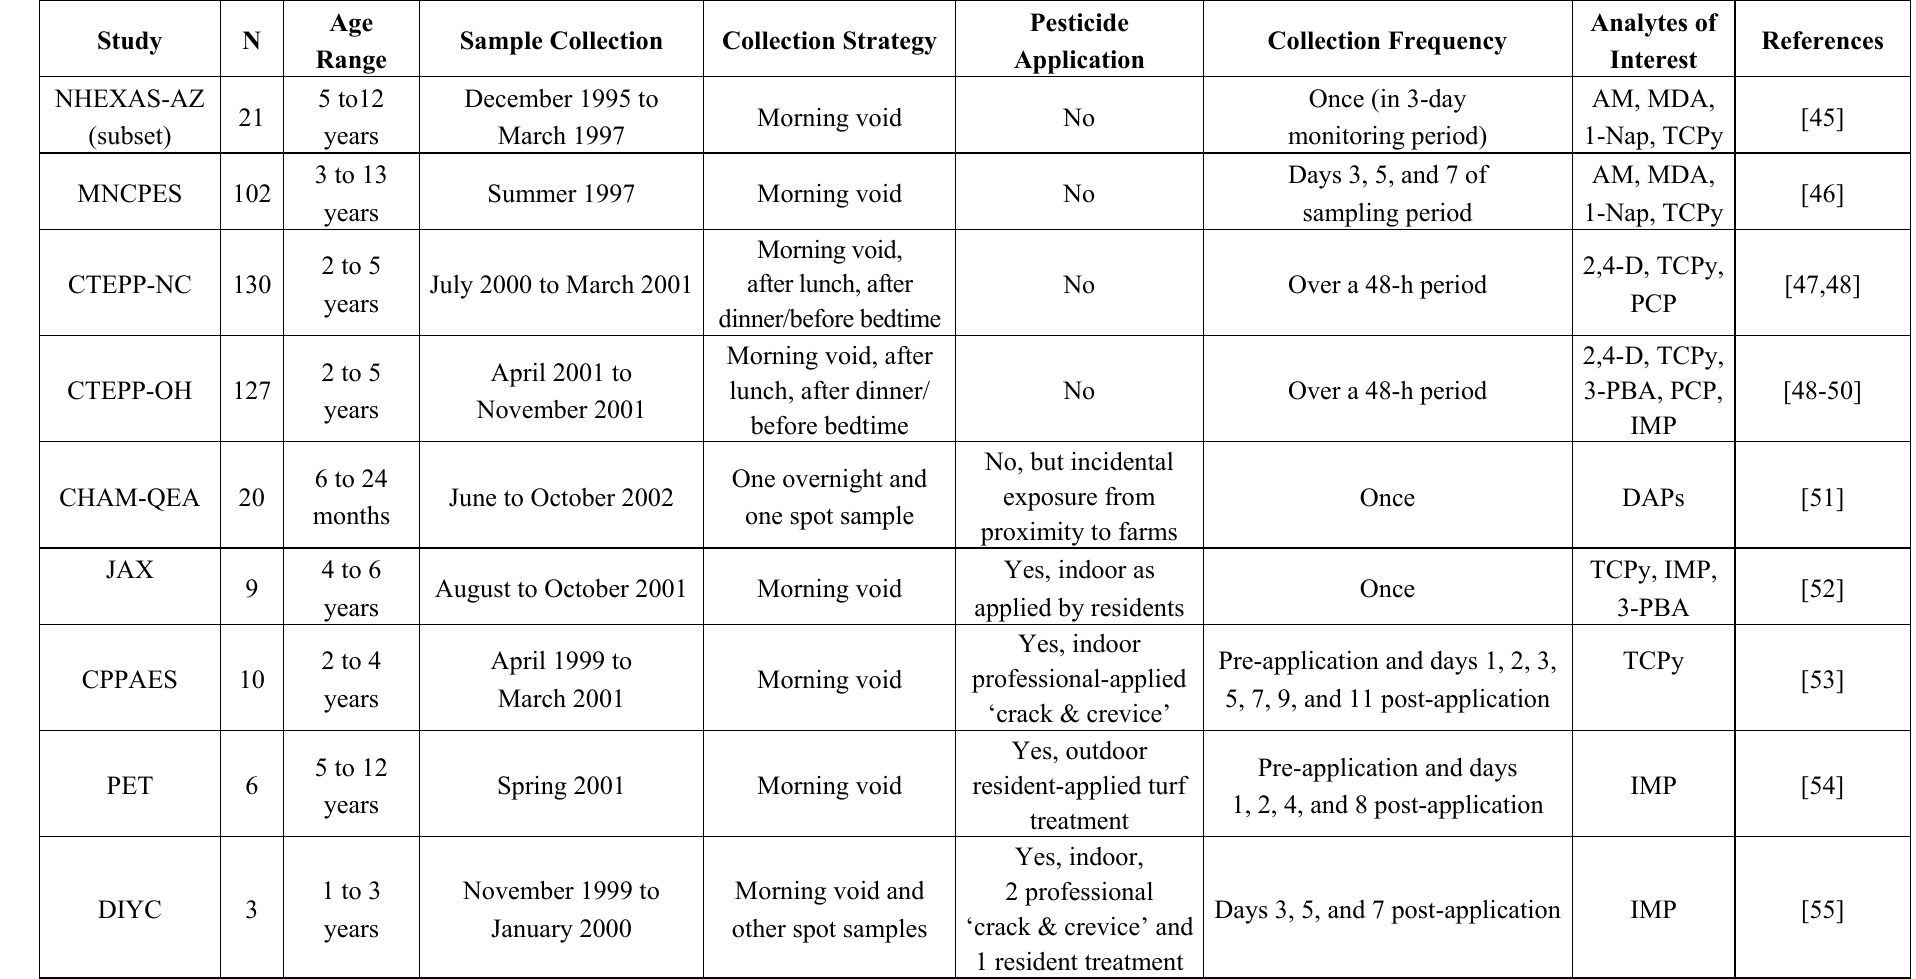
Table 2. Summary of the children’s urinary biomarker collection